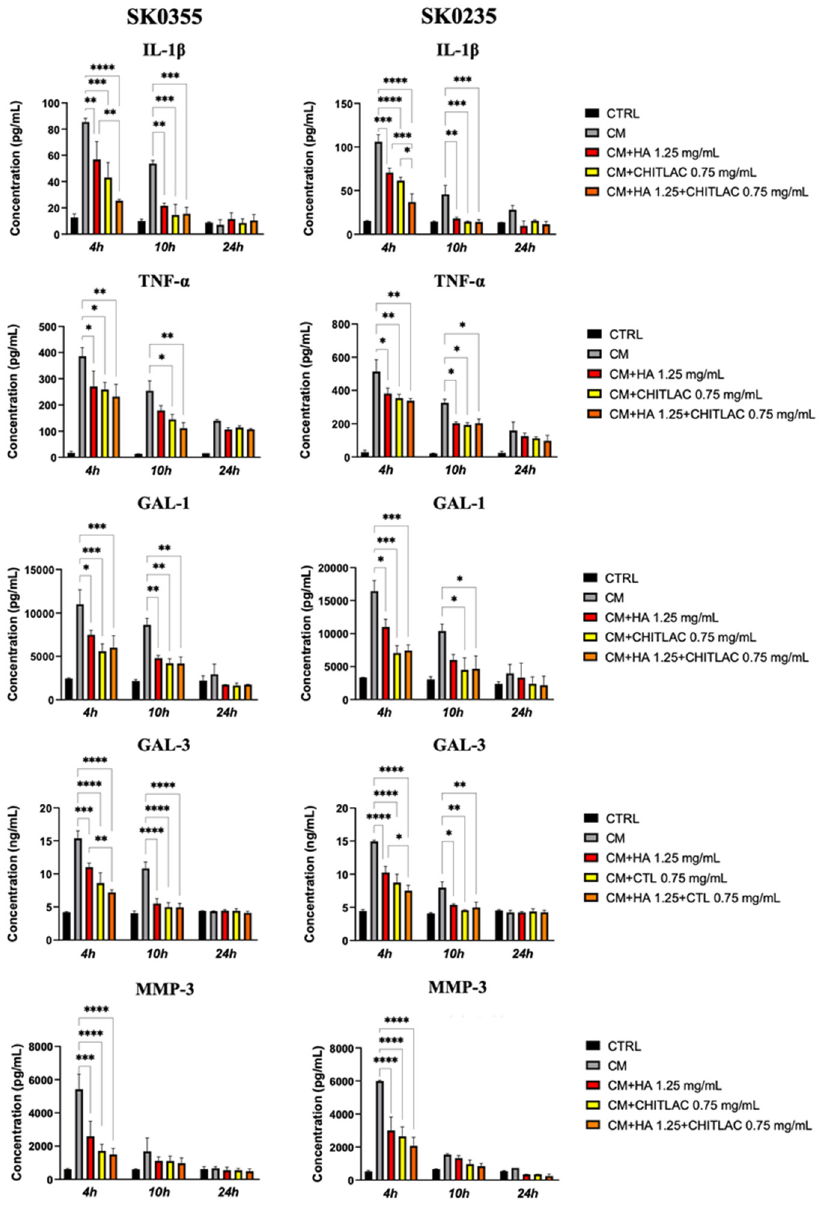
Figure 8. IL-1 β , TNF- α , GAL-1, GAL-3 and MMP-3 protein expression in dermal fibroblasts after exposure to U937 CM in the presence or absence of HA, CTL and HA-CTL mixture. Human dermal fibroblasts SK0355 from a 30-year-old woman and SK0235 from a 54-year-old woman were cultivated in the presence or absence of 1.25 mg/mL HA, 0.75 mg/mL CTL, or their mixture after 24 h of exposure to activated U937 CM. At 4, 10 and 24 h following treatment, ELISA was used to analyse